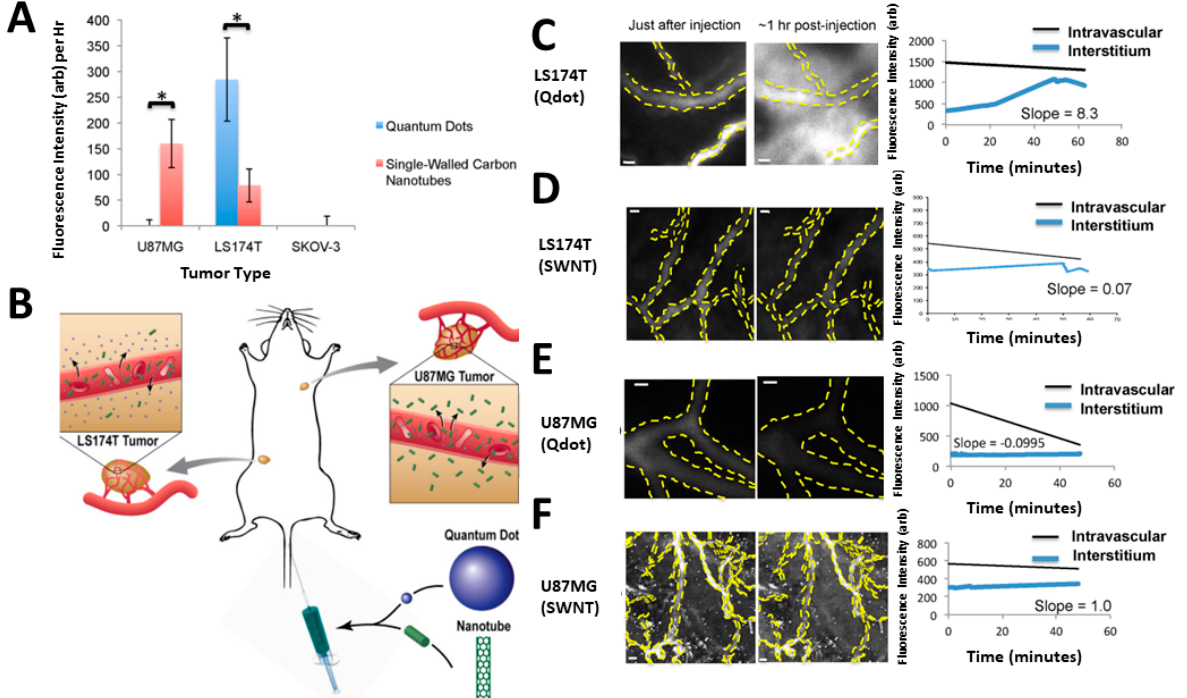
Figure 4. ( A ) The quantum dot extravasation contrasted to SWNTs for every single cancer form. * Indicates p < 0.05. ( B ) An overview of the NP outburst. ( C ) At around 1 h of the treatment, the quantum dot in LS174T cancer strongly exits the vascular system. ( D ) Furthermore, SWNTs are not extravasated as compared to the quantum dot. The scale bars of ( C , D ) denote 20 µ m ( E ) In U87MG cancer, the quantum dot does not extravasate out from the circulation. Scale bar signifies 10 µ m ( F ) Autofluorescence is seen in the SWNT scenario in the photos taken soon following administration. Scale bar signifies 50 µ m. Re-printed with permission from reference [161]. Copyright (2012), American Chemical